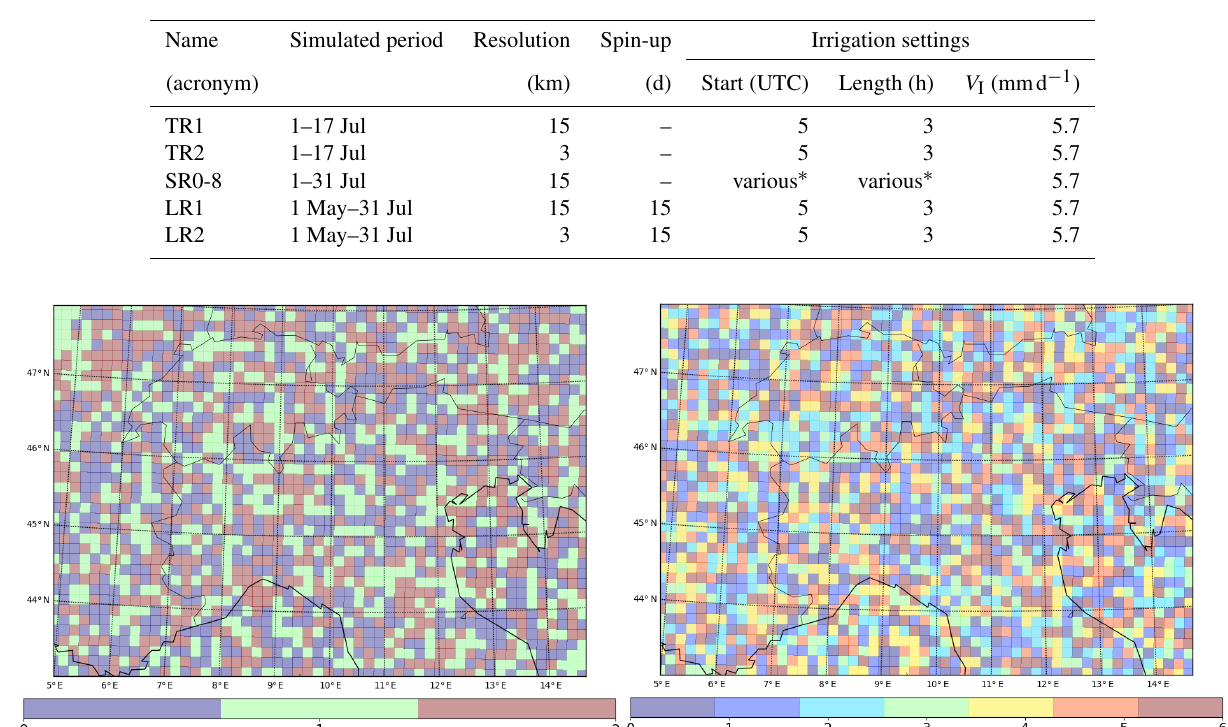
Table 1. Table with the experiments used in this paper: the main features of them are summarized here. For further explanations, refer to the main body text.“various ∗ ” refers to the various settings that for simplicity reasons are described in Table 2.